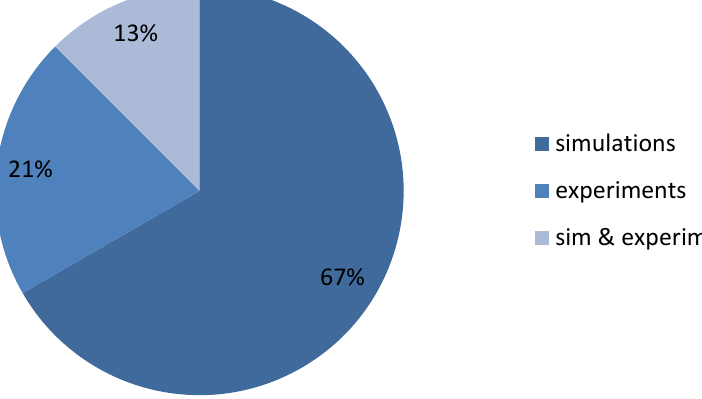
Figure 10. A comparison of analyzed approaches: verification